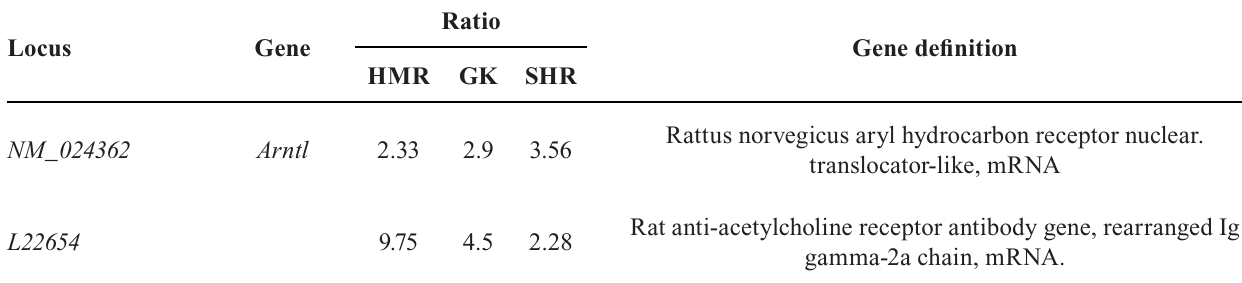
TABLE III - Genes downregulated in hyperlipidemia, diabetes and hypertension groups